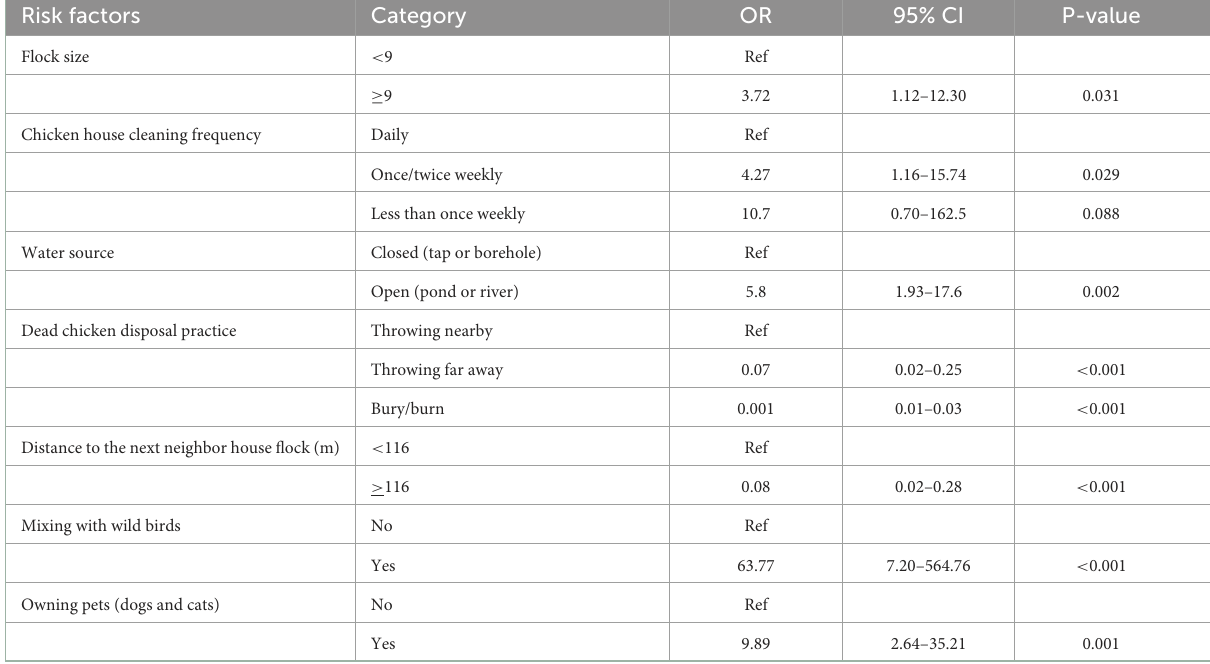
TABLE 5 Multivariable logistic regression for Household level risk